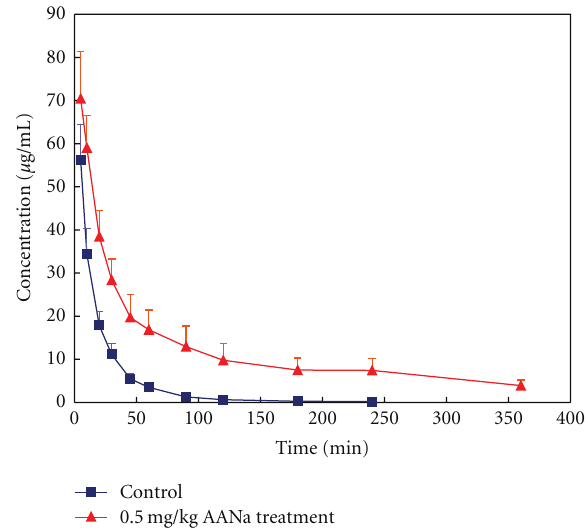
Figure 1: Plasma concentrations of p -aminohippuric acid (PAH) after iv administration of 0.5mg/kg aristolochic acid sodium (AANa) to rabbits ( n = 10).